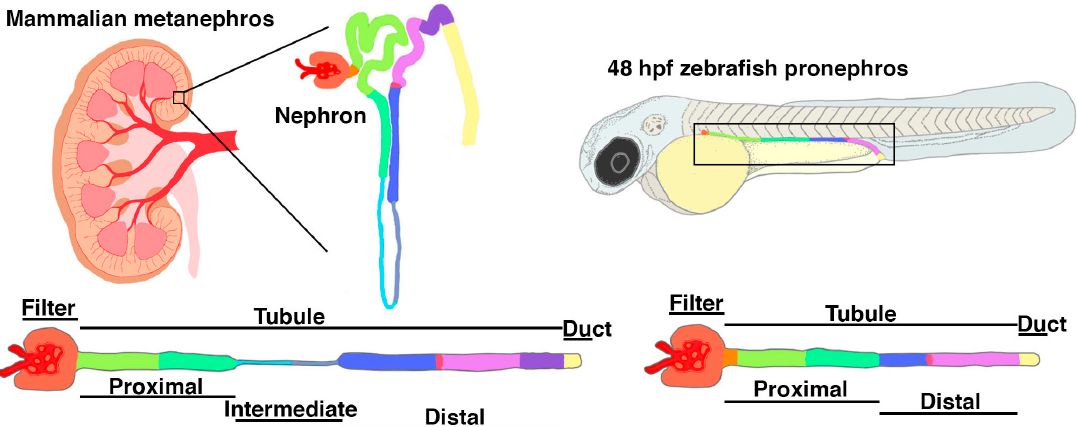
Figure 4. Nephron composition and segment pattern is conserved between zebrafish and mammals. Nephrons in the mature mammalian metanephric kidney are composed of a renal corpuscle followed by proximal, intermediate, and distal tubule segments. This anatomical pattern is conserved in the zebrafish pronephros, which form a renal corpuscle at the midline which sends filtrate to the pair of nephrons that contain a series of proximal and distal segments. The podocytes and tubule cells in zebrafish express a shared suite of conserved genetic markers in common with mammals.